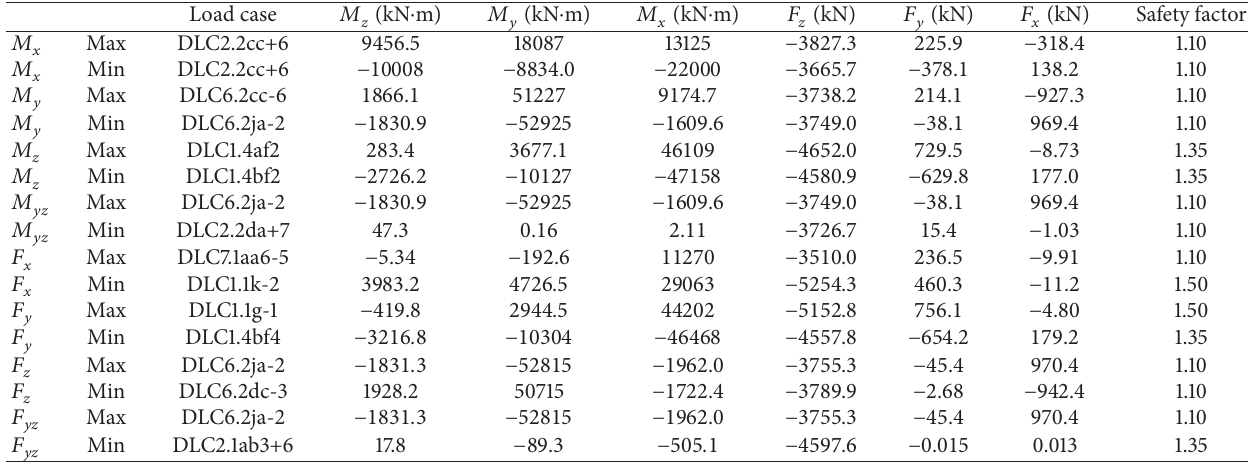
Table 12: Extreme values at TP due to extreme wind.